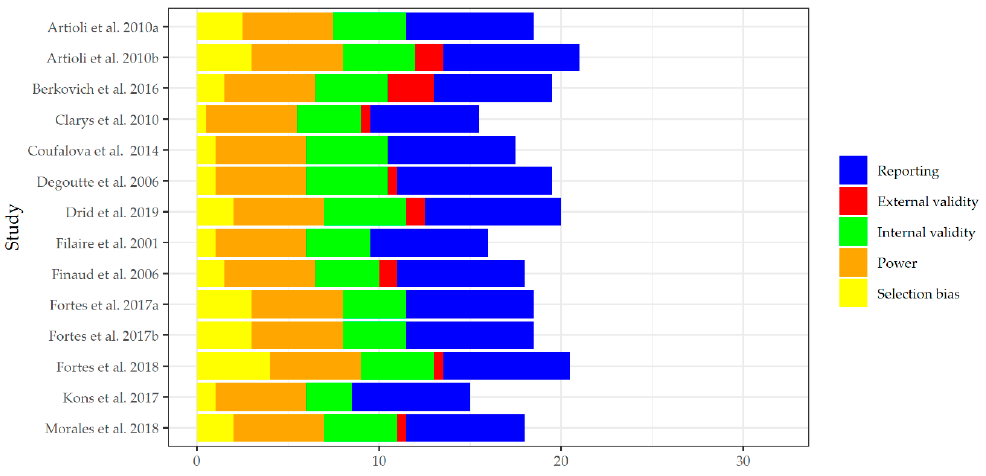
Figure 2. Risk of bias assessment [15].